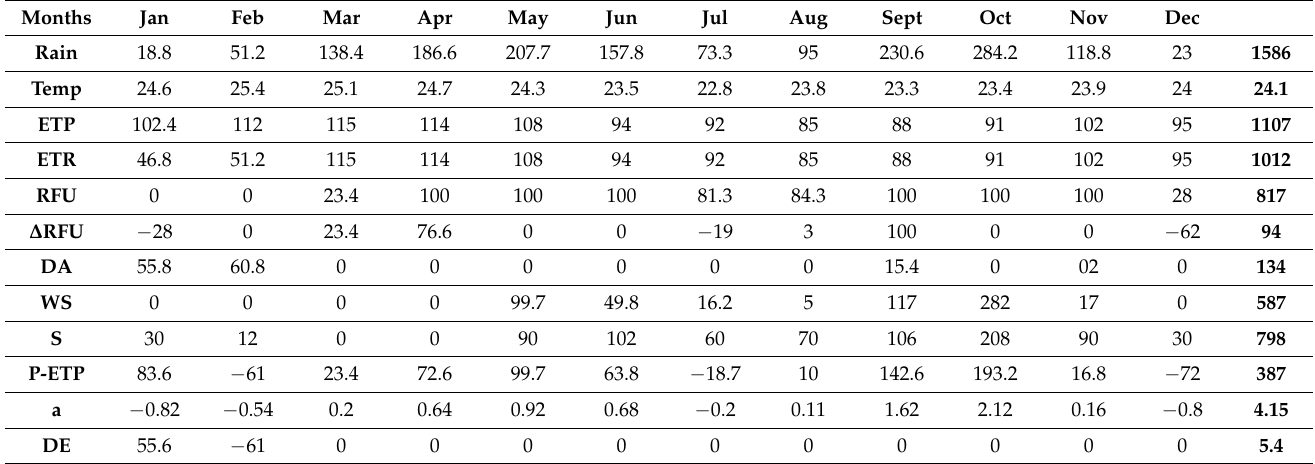
Figure 6. Map of seasonal piezometric fluctuations of the Nkoabang aquifer.(P1): Nkolo I; (P2): Nkolo II (near the solidarity health centre); (P3): at the Etambè primary school; (P4): Etambè Catholic church; (P5): Nkolo I (near to the chief ’s hut); (P6 et P7): Nkolo I (near the fountain). Table 3. Hydricbalanceparameters(uncertainty: ∓ 1mm),